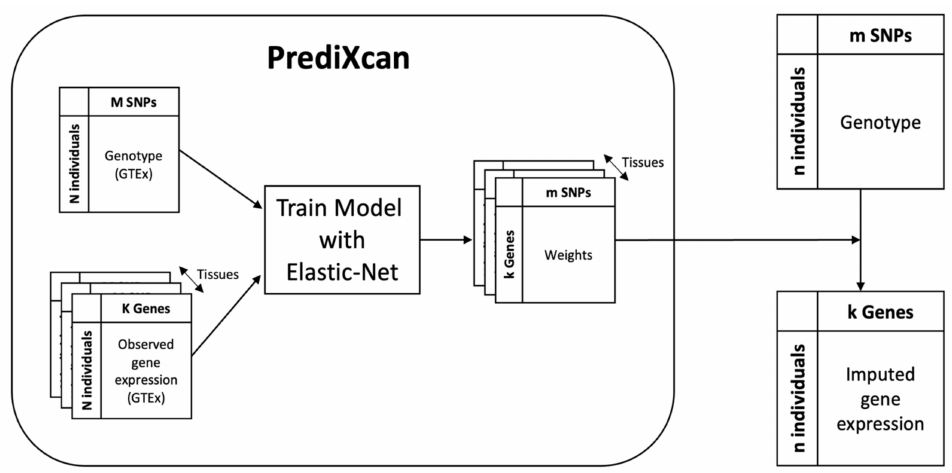
Figure 1. Overview of imputing gene expression from genotype. The PrediXcan models (round- cornered box) were downloaded from https://predictdb.org (accessed on 21 April 2021). They were developed for a number of tissues using the matched genotype and gene expression datasets compiled by the GTEx consortium. A given gene’s expression value was linearly modeled from the genotypes of neighboring single-nucleotide proteins (SNPs), which was selected through elastic net. By applying the linear regression weights to our genotype data (upper right), we were able to impute the gene expression in our tissue of interest (lower